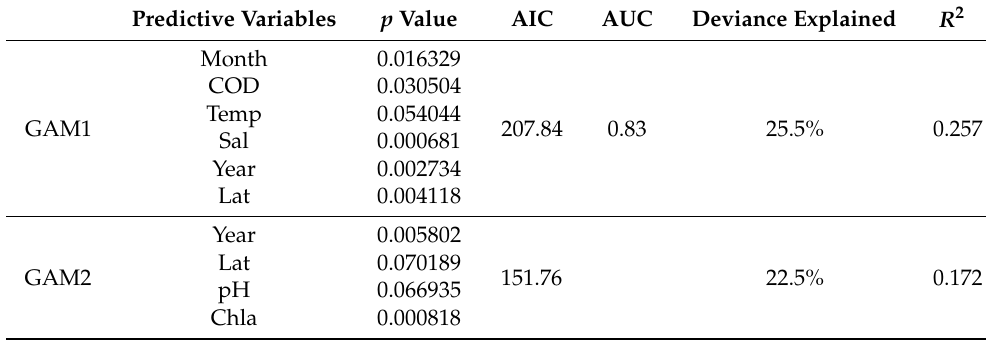
Table 2. Summary of variables and model performances of the generalized additive models